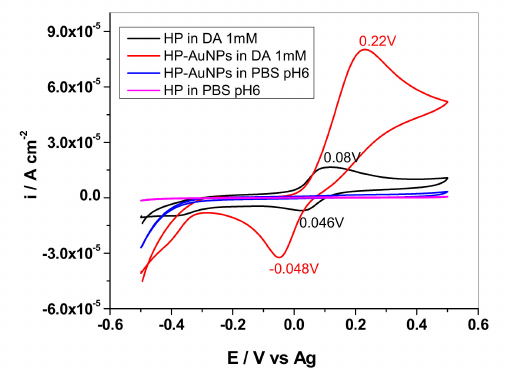
Figure 6. Cyclic voltammograms recorded with HP and HP-AuNPs flexible electrodes in the absence and presence of 1 mM dopamine. Supporting electrolyte: pH 6 phosphate-bu ff ered saline (PBS); scan rate 10 mVs − 1